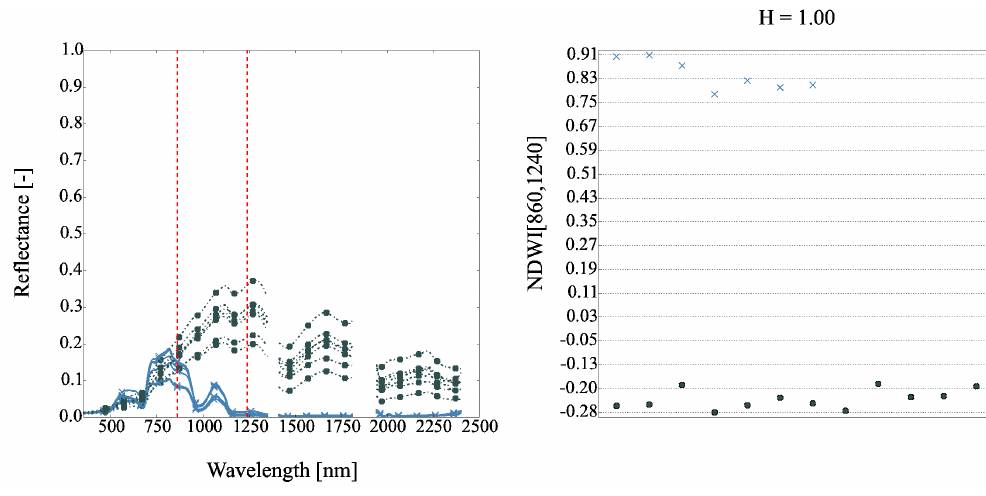
Figure 8. ( Left ) spectral signatures of AQ_B (blue) and AQ_C (dark slate gray). Red dashed lines are the wavelengths used by the Normalized Difference Water Index (NDWI) [860,1240] index; ( Right ) NDWI [860,1240] values for each vegetation type, H is the Hellinger distance.